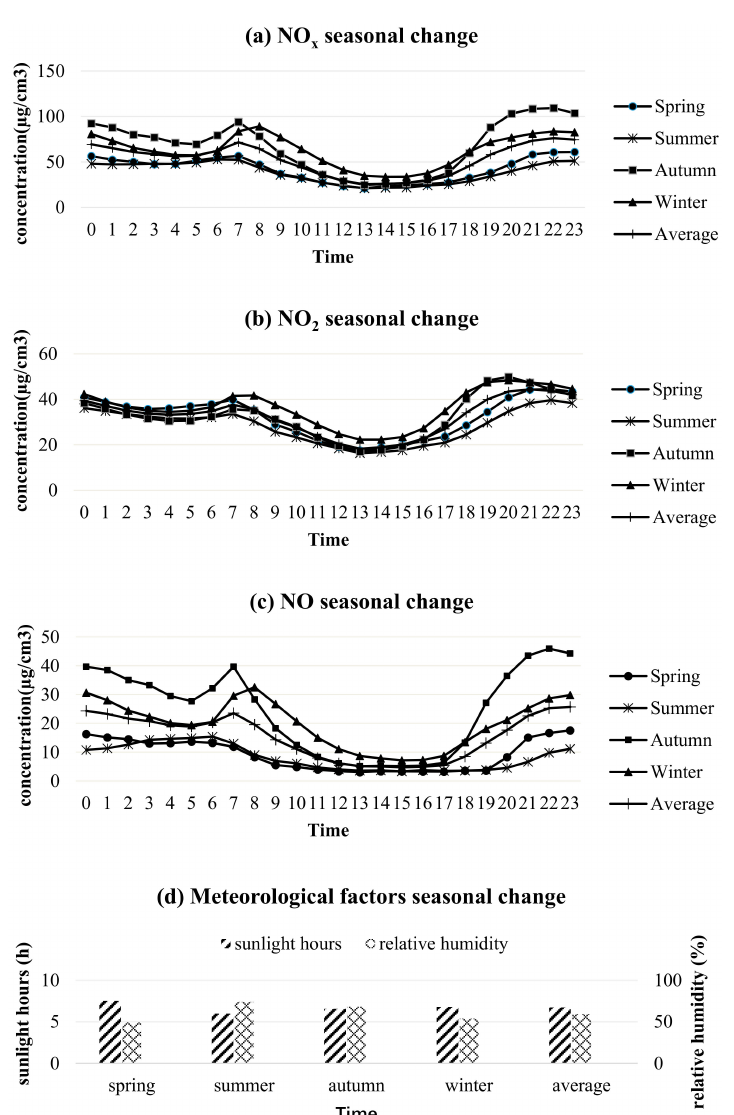
Figure 3. Concentrations of nitrogen compounds and meteorological factors in the four seasons of Changchun in 2018: ( a ) NO x , ( b ) NO 2 , ( c ) NO, ( d ) sunlight hours and